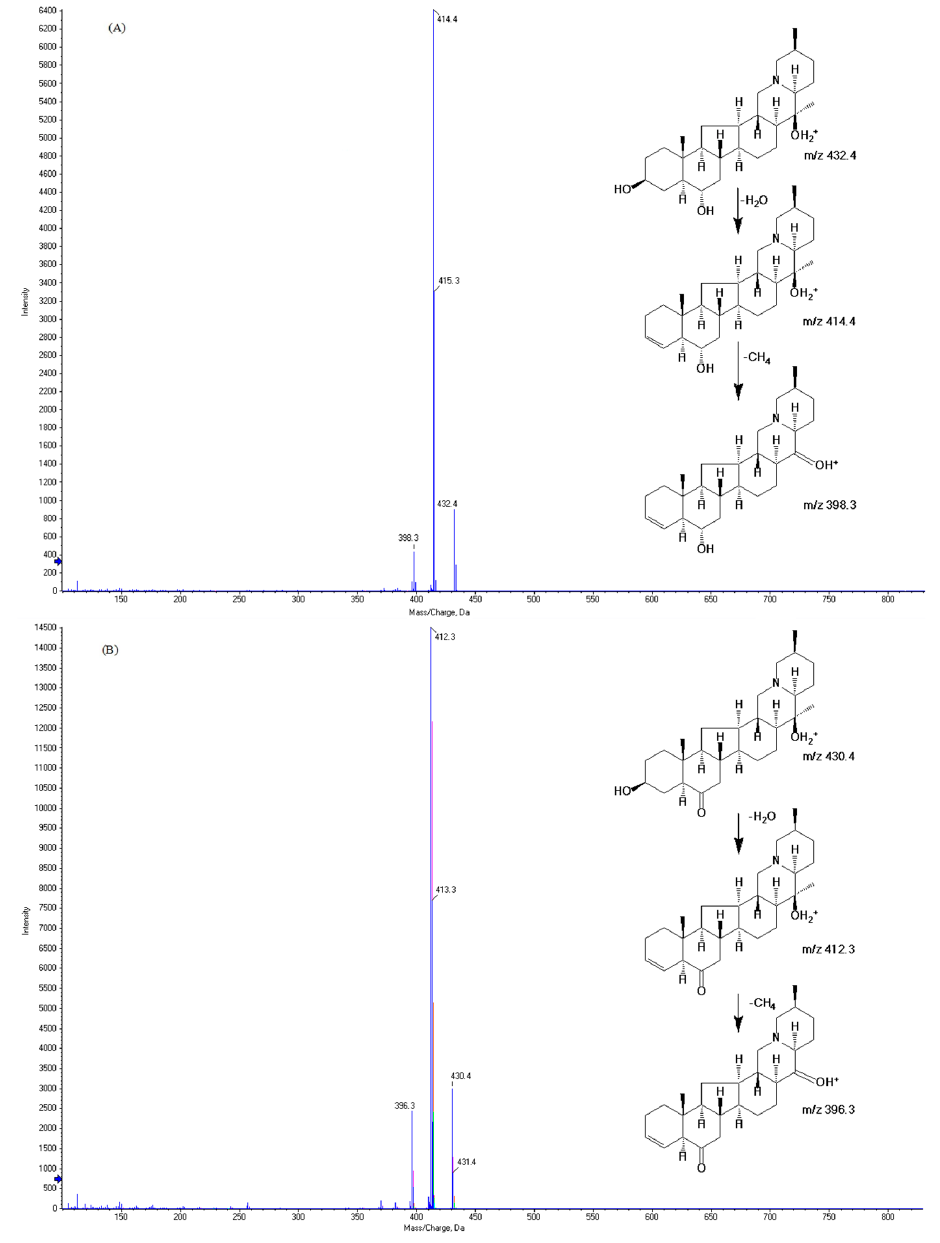
Figure 1. MS/MS fragmentation patterns of peimine ( A ) and peiminine ( B ).